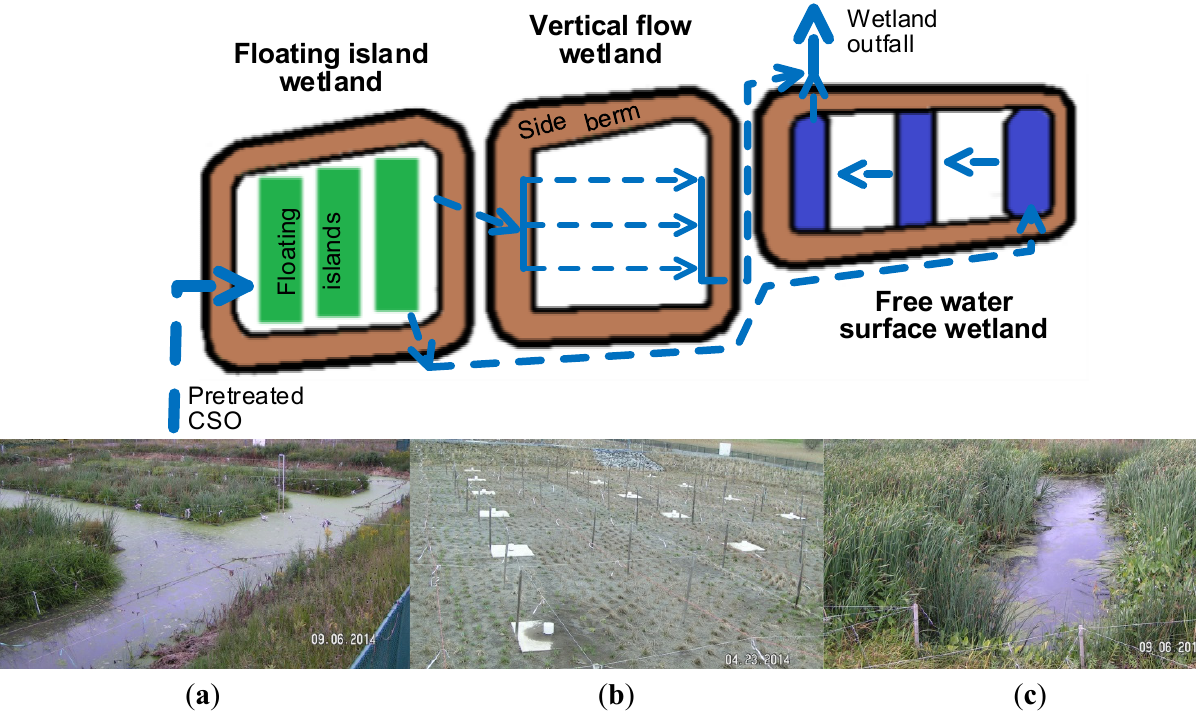
Figure 1. Layout of Harbor Brook CSO constructed wetlands in series/parallel operation with pictures showing pre-operation status. The pictures were taken by W. Tao, showing the floating island wetland with three vegetated floating mats ( a ); vertical flow wetland with white risers over concrete splash pads ( b ); and a deep water zone and vegetation of the free water surface wetland ( c